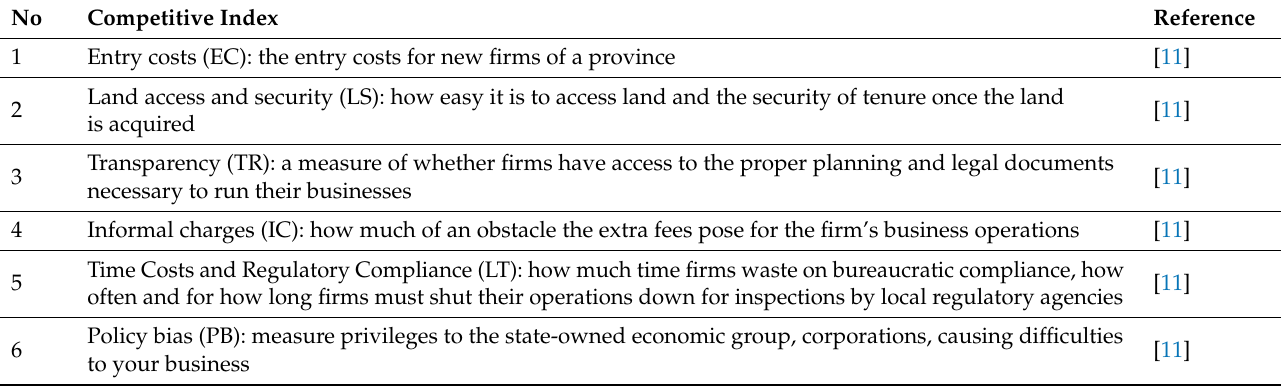
Table 1. Definitions of PCI